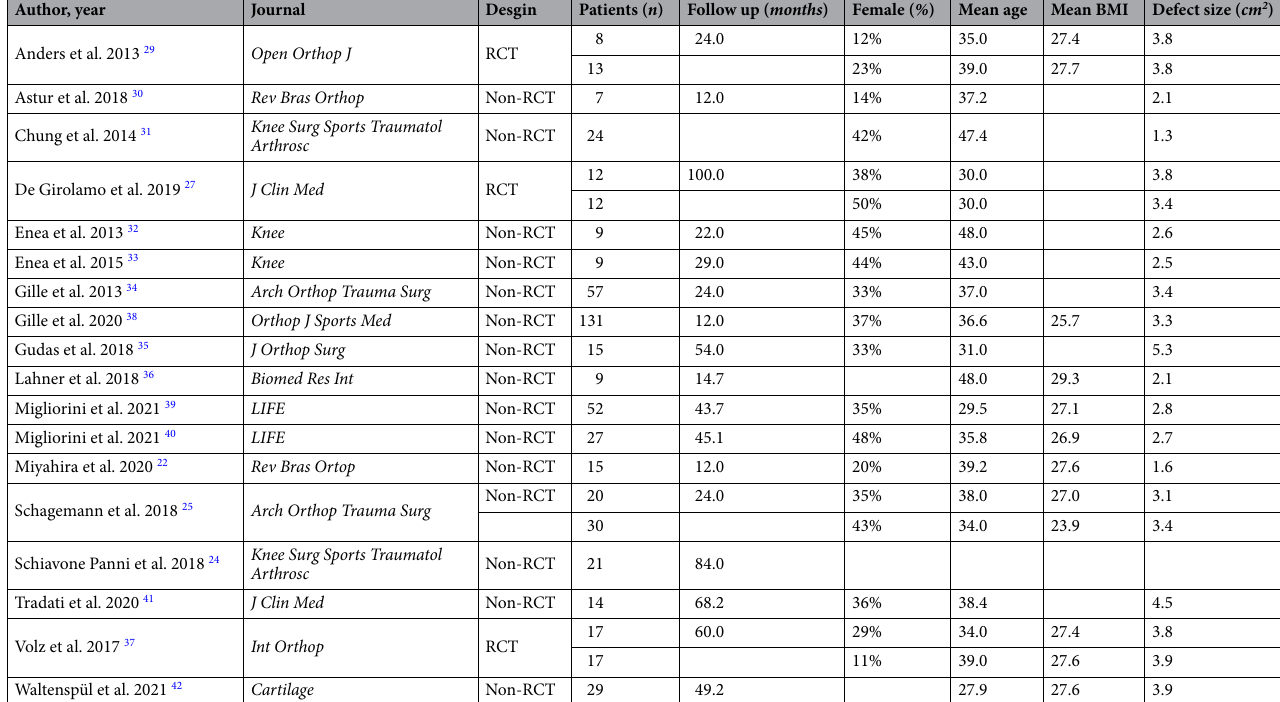
Table 2. Generalities and patient baseline of the included studies (RCT: randomised controlled trial).